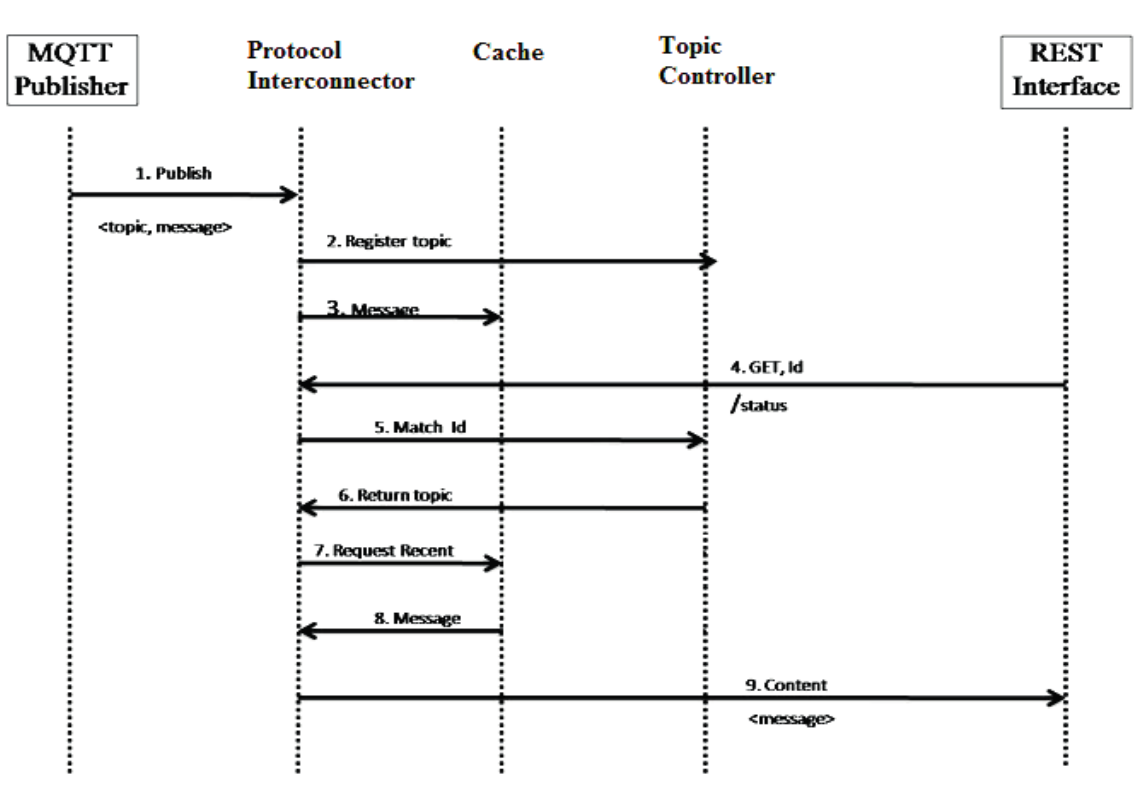
Fig. 3. Communication between mQtt publisher and rest